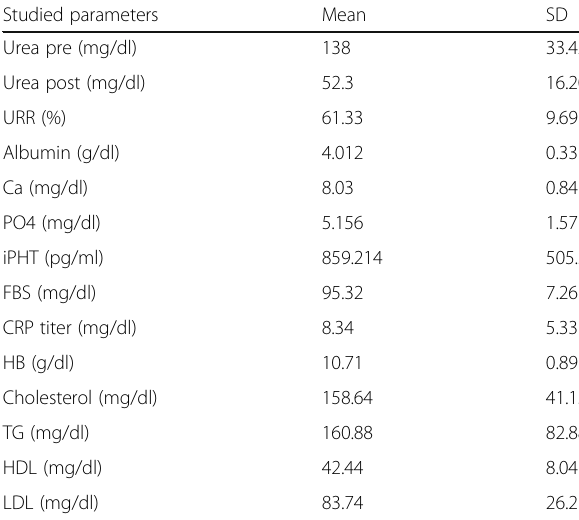
Table 2. Among patients with decreased MFV in MCA